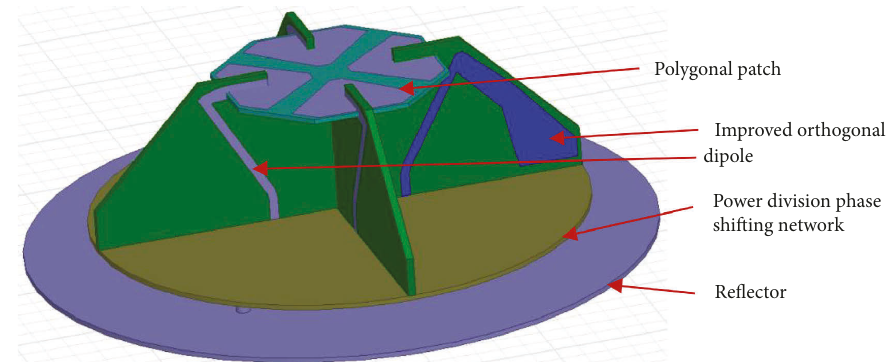
Figure 1: Geometry of the proposed antenna.